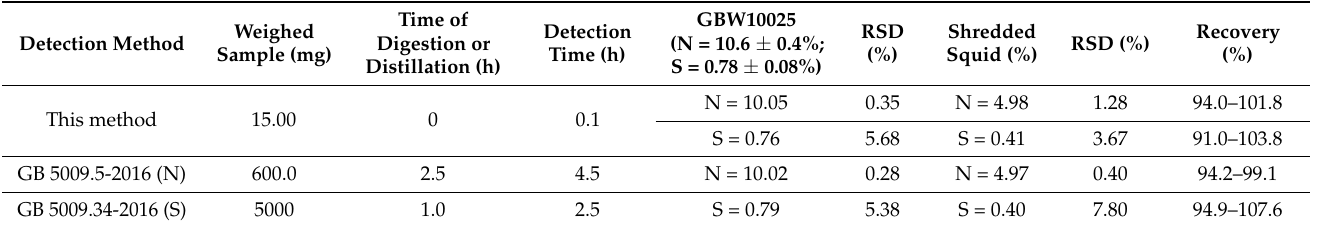
Table 6. Comparison between this method and national standard methods for N and S content detection in food (n